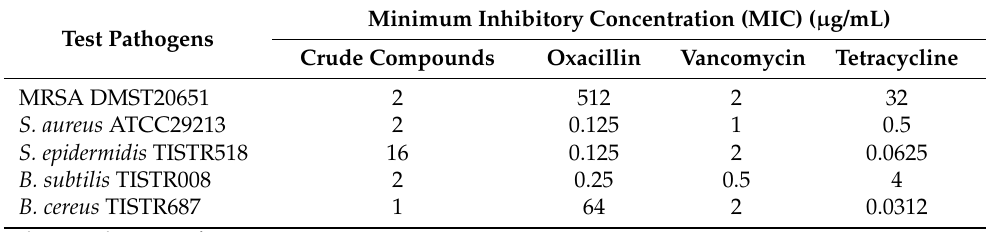
Table 3. The MIC values of Streptomyces sp. PJ85 crude ethyl acetate against test